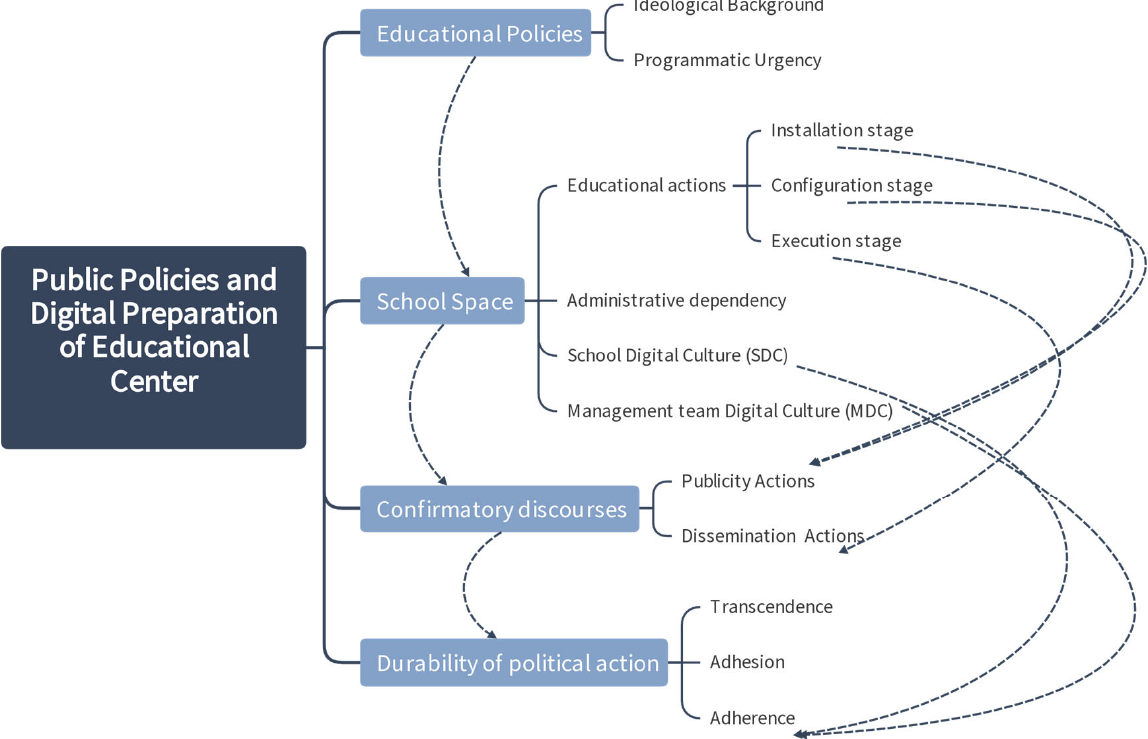
Figure 2. Interconnected elements in the execution of public policies in education. Source: author.